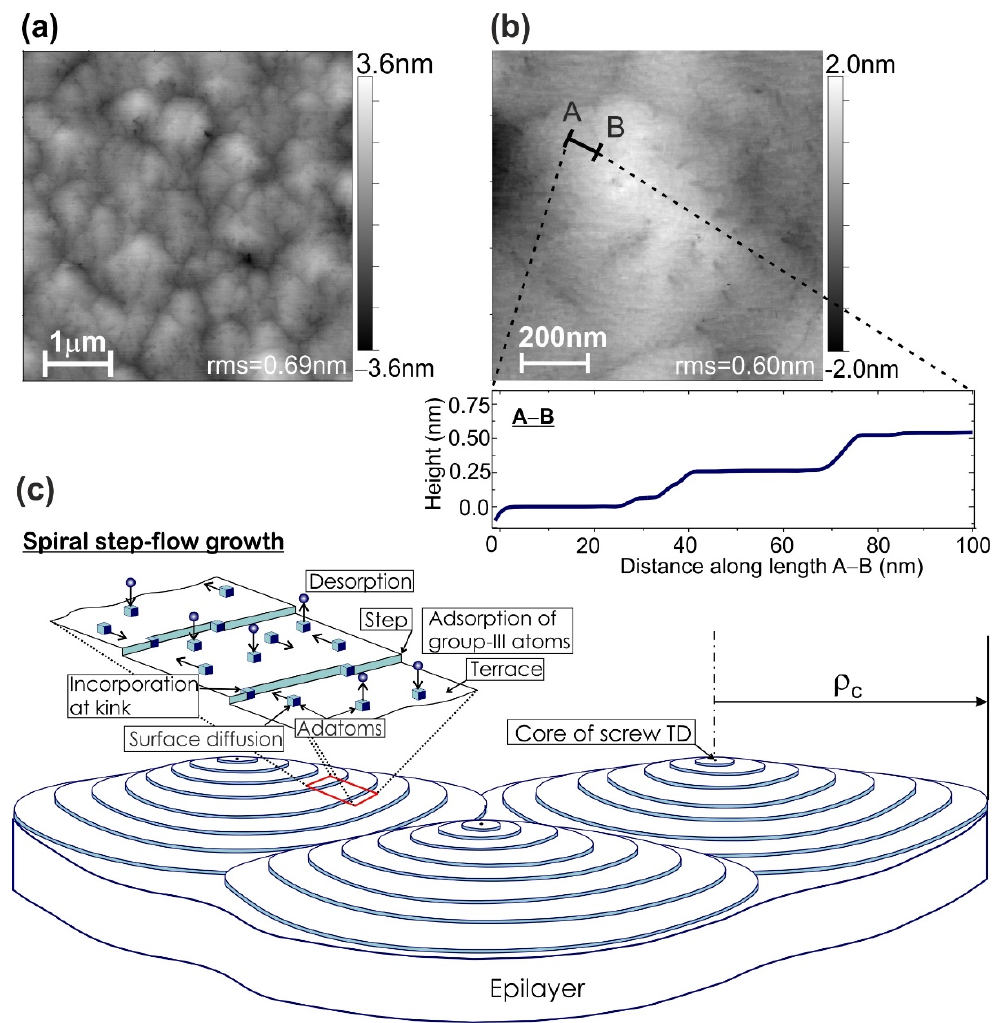
Figure 1. AFM images of the AlN buffer layer with a root mean square (rms) roughness of 0.69 and 0.60 nm, measured in the scanned areas of 5 × 5 µm 2 ( a ) and 1 × 1 µm 2 ( b ). Insertion shows the surface height profile measured along A–B length in ( b ). ( c ) Schematic diagram of spiral step-flow growth of III-Nitrides with inset illustrating the terrace–kink model of adatoms incorporation.